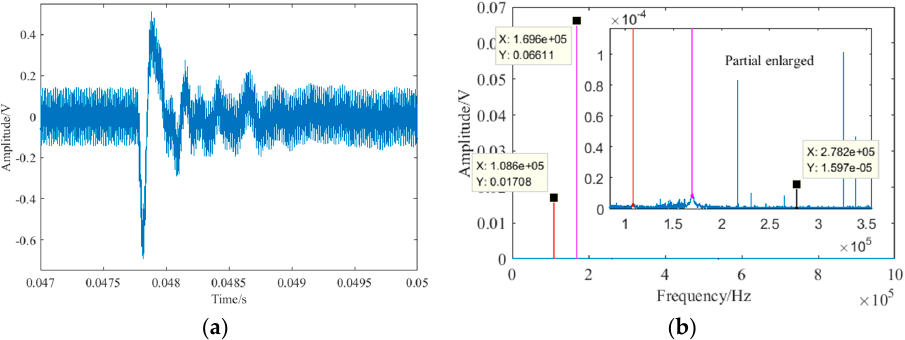
Figure 15. The received impact signal of 500 mm: ( a ) local details of impact response in the time-domain; ( b ) impact signal in the frequency-domain.